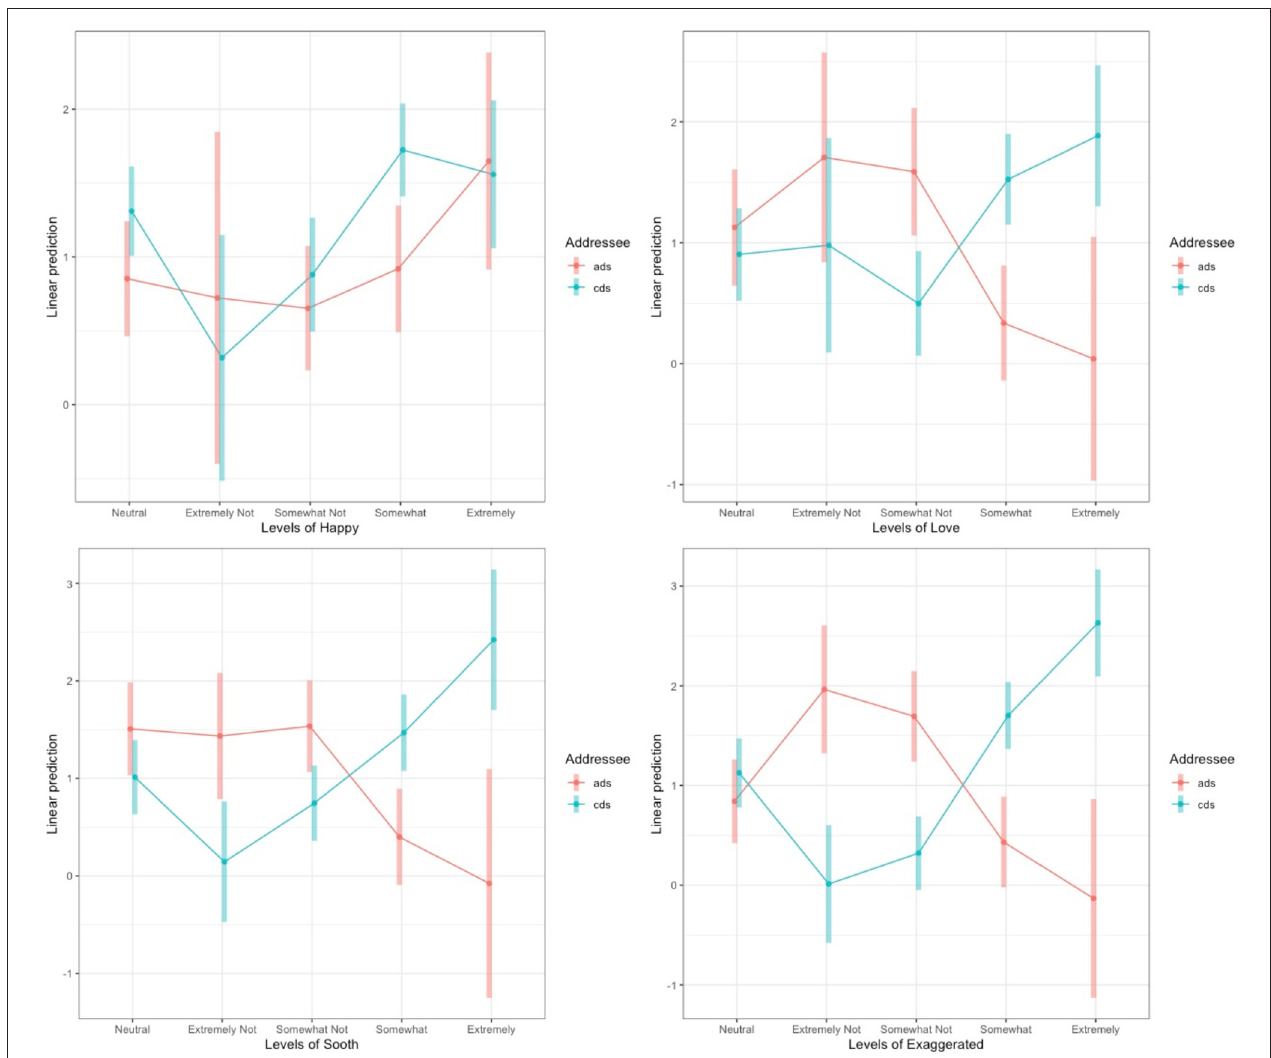
FIGURE 2 | Levels of sounded Happy (top left), sounded Loving (top right), sounds Soothing (bottom left), and sounded Exaggerated (bottom right) for the interactions with Addressee for Experiment 1. The log odds of each affect level are plotted on the y-axis and the shaded areas represent the 95% CIs. The interactions between Addressee and Loving, Soothing and Exaggerated were significant. Neutral is graphed on the left as it was the reference